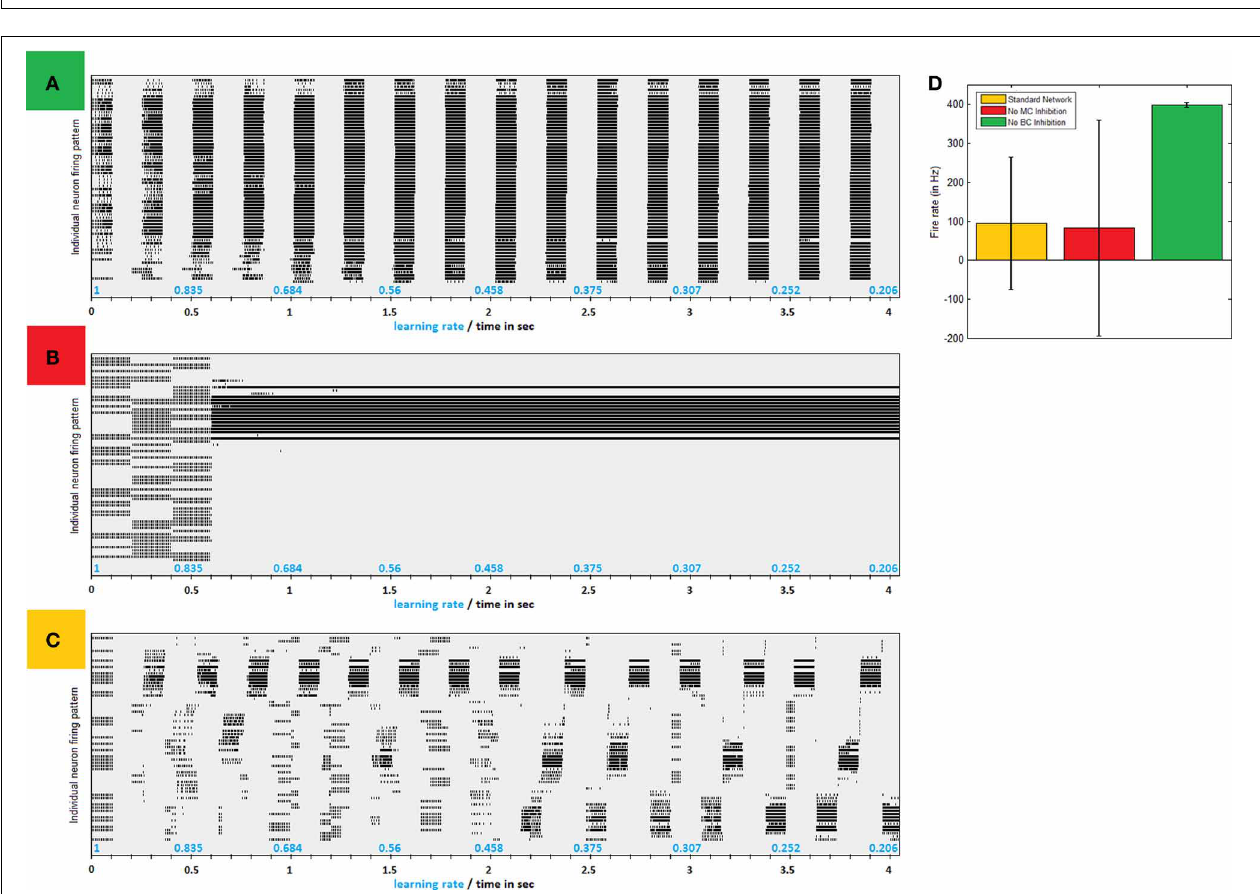
than connected LBCs. (B) Illustration of structure topology. Activation of central PC immediately drives connected PCs while inhibiting others which are connected via basket cell lateral inhibition. It also inhibits its own local neighborhood within a certain delay, the effect attributed to Martinotti cells.